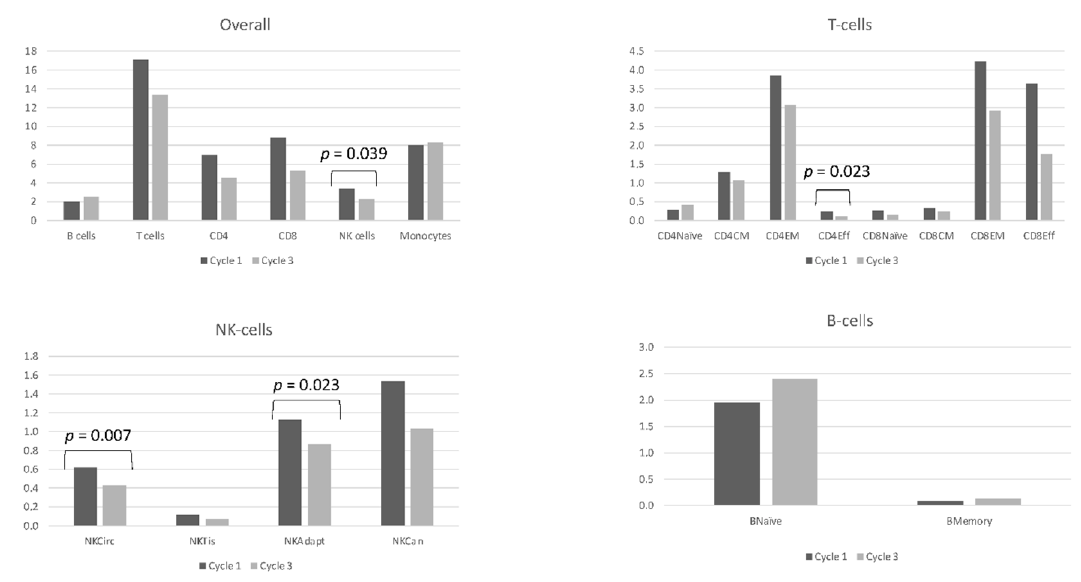
Figure 4. Percentages of the main immune cell populations and subpopulations in peripheral blood at baseline and after receiving two cycles of pembrolizumab. Dark-grey bars correspond to baseline values and light-gray bars correspond to those obtained at day 1 of cycle 3. Statistically significant differences in the percentage of cell populations between both timepoints are highlighted with their corresponding p -value.